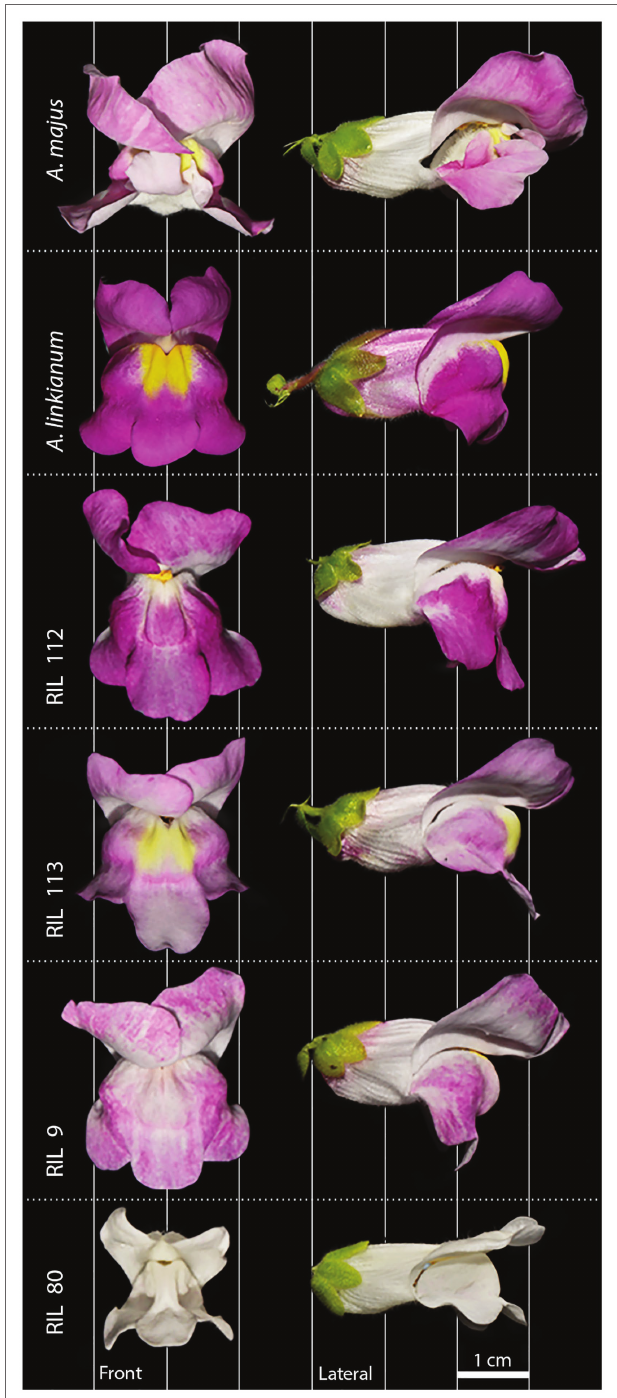
FIGURE 1 | Flowers from lines used for experiments. Parental species: Antirrhinum majus and Antirrhinum linkianum . Recombinant Inbred Lines (RILs): 112, 113, 9, and 80. Front and lateral